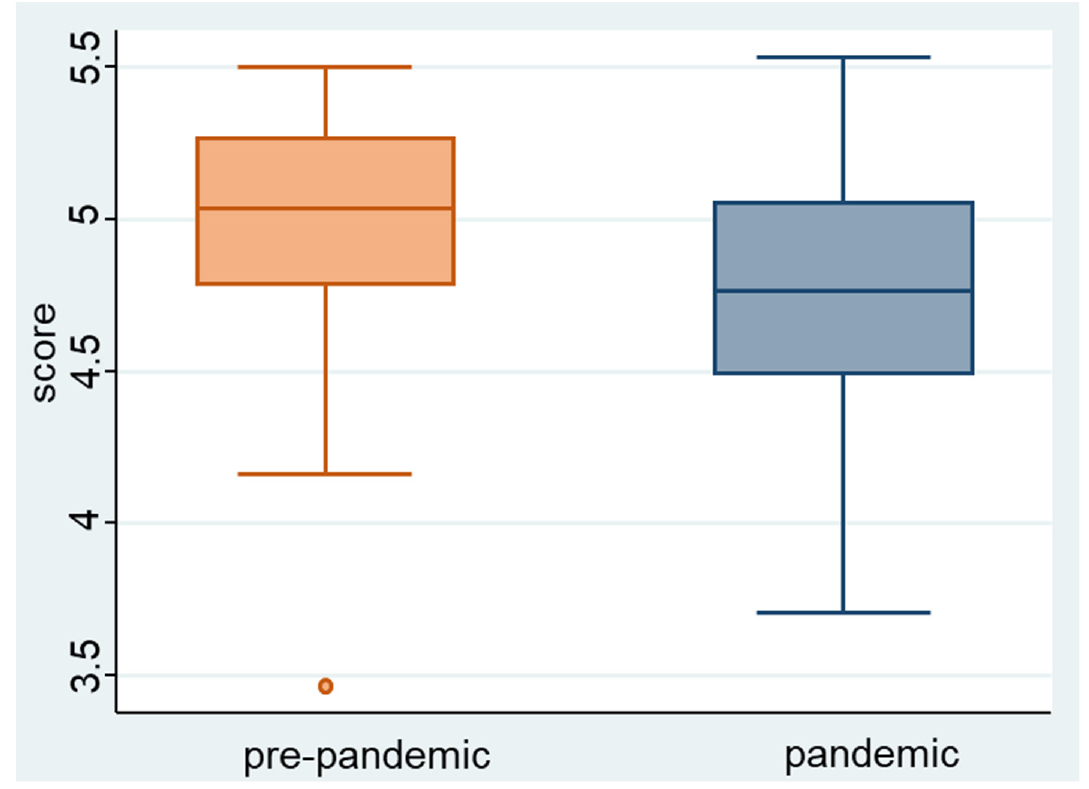
Figure 1. Examination score by period As the canton of origin differs among groups (Table 1), a sensitivity analysis was conducted by analysing only the subjects issued from the canton of Geneva. Among